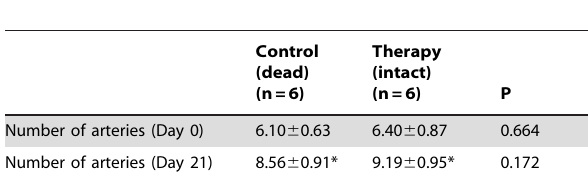
Table 1. Evaluation of MR angiography after transplantation of manganese-labeled mononuclear cells.